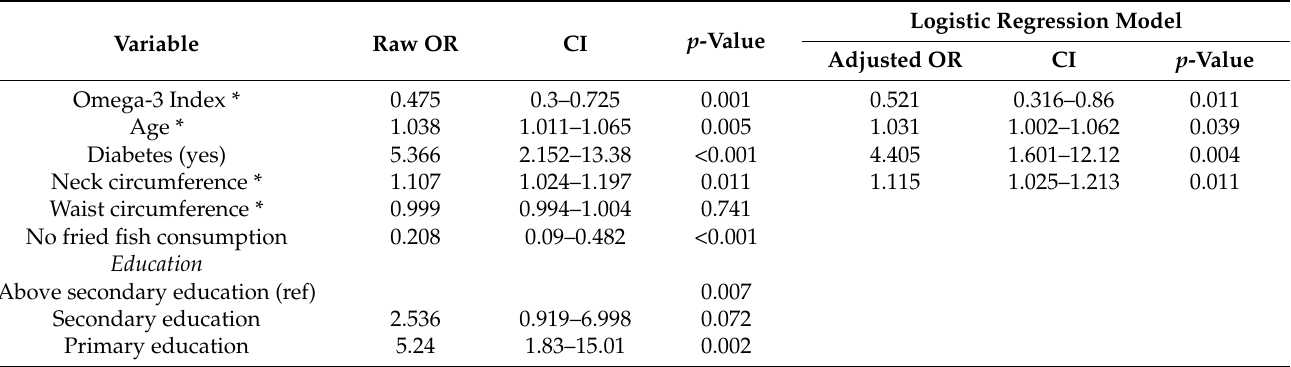
Table 3. Raw ORs and logistic regression model of variables influencing the clinical outcome of SARS-CoV-2